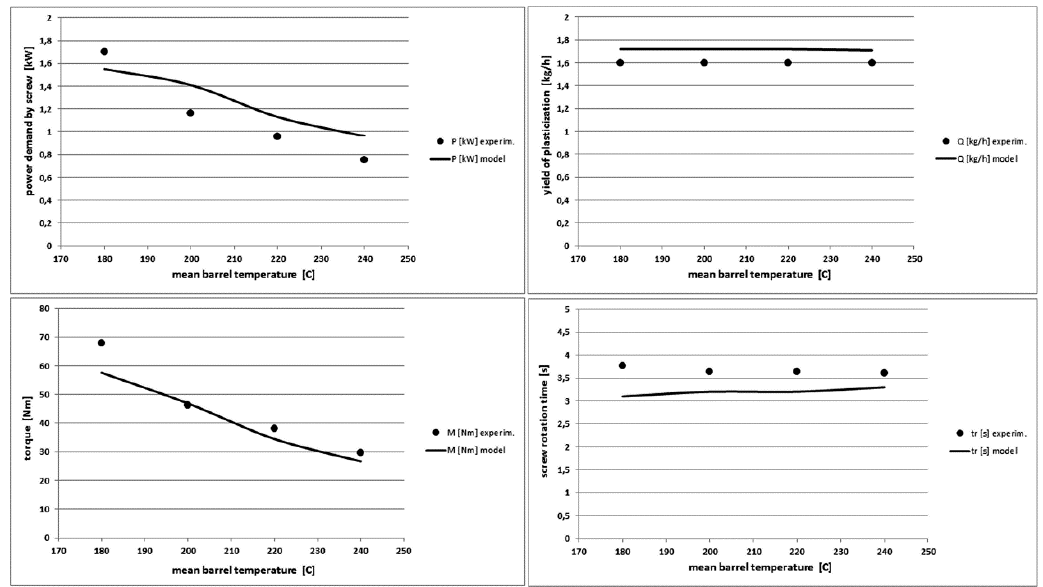
Figure 15. Comparison of other theoretical and experimental characteristics for different mean barrel temperature values in PS injection process.